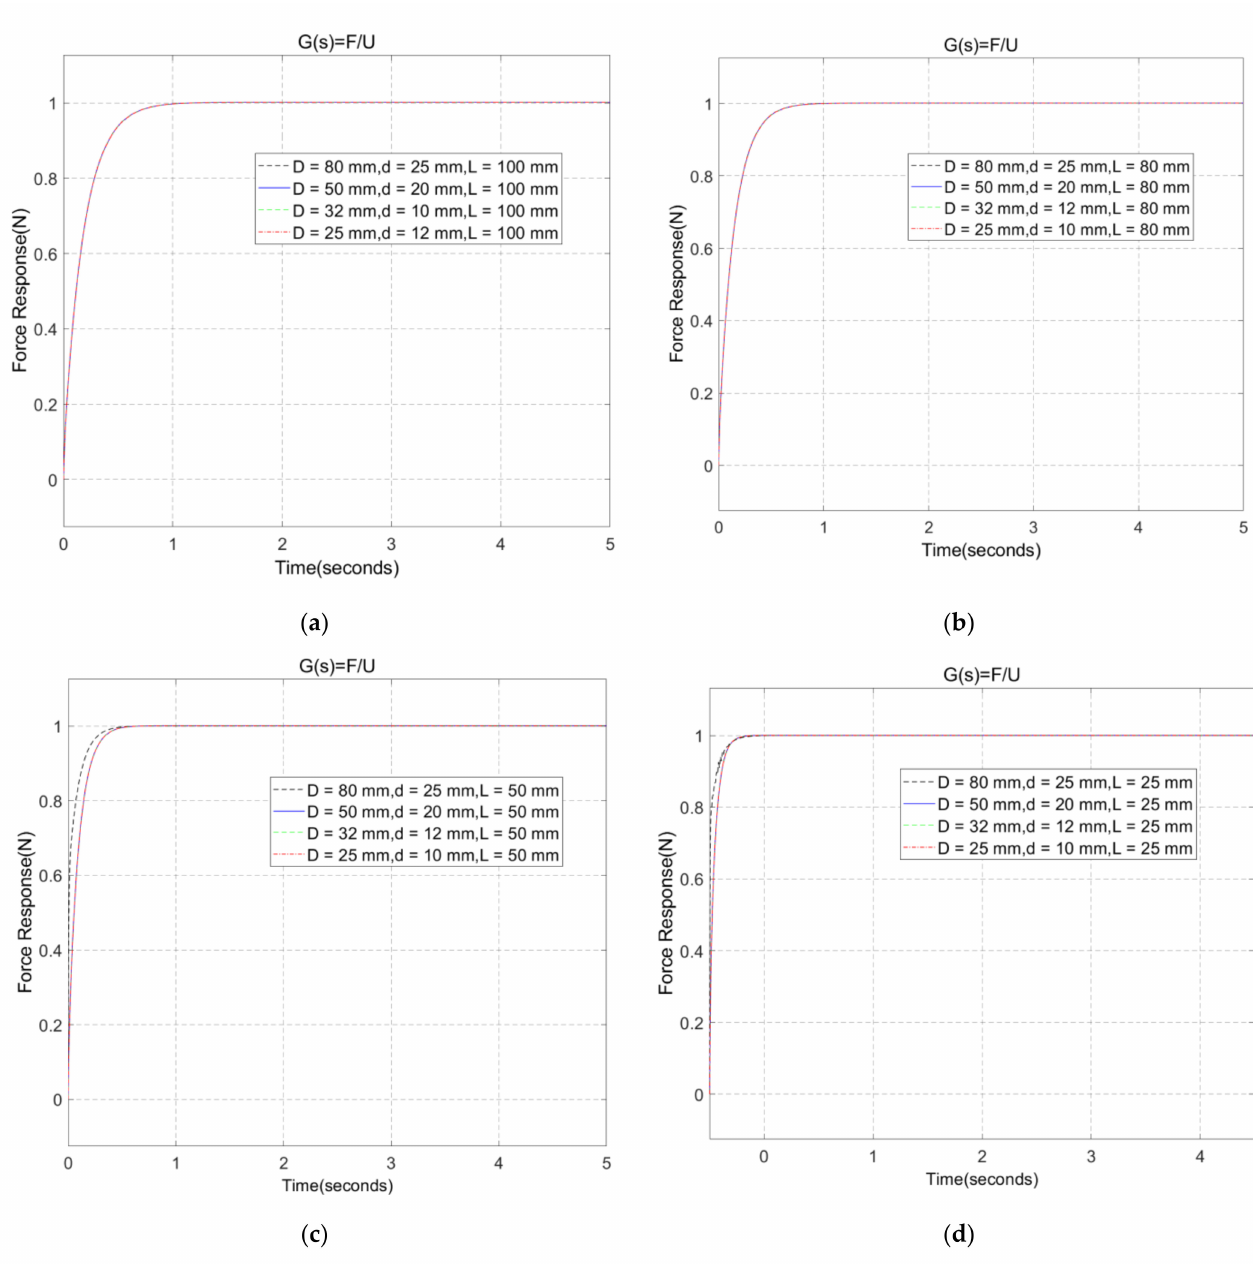
Figure 17. Force response curves with different cylinder diameters and the same stroke. ( a ) L = 100 mm; Table 4. The average steady-state